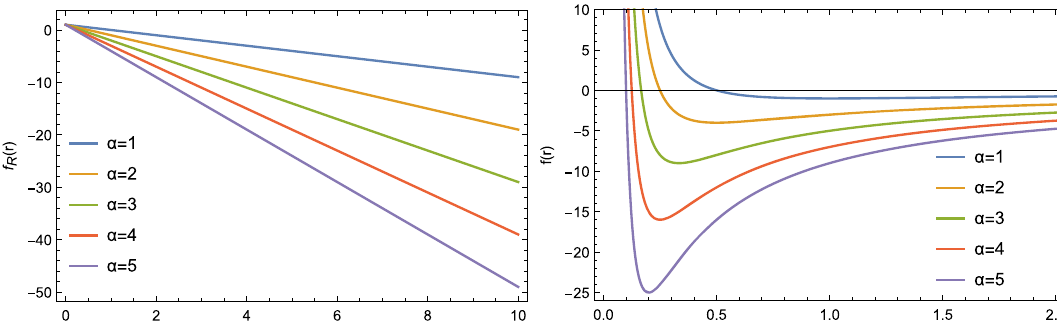
Fig. 1 Quantities related to the f ( R ) model: f R ( r ) and f ( r ) for different values of the parameter α